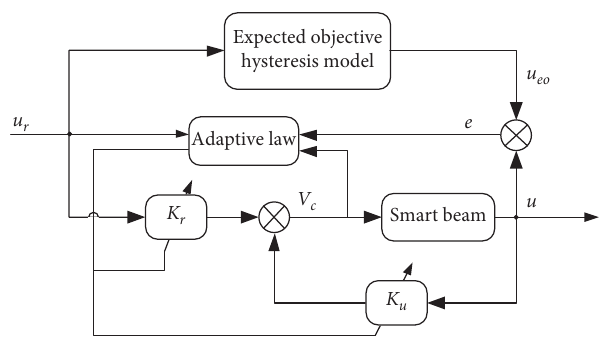
Figure 5: Model reference adaptive